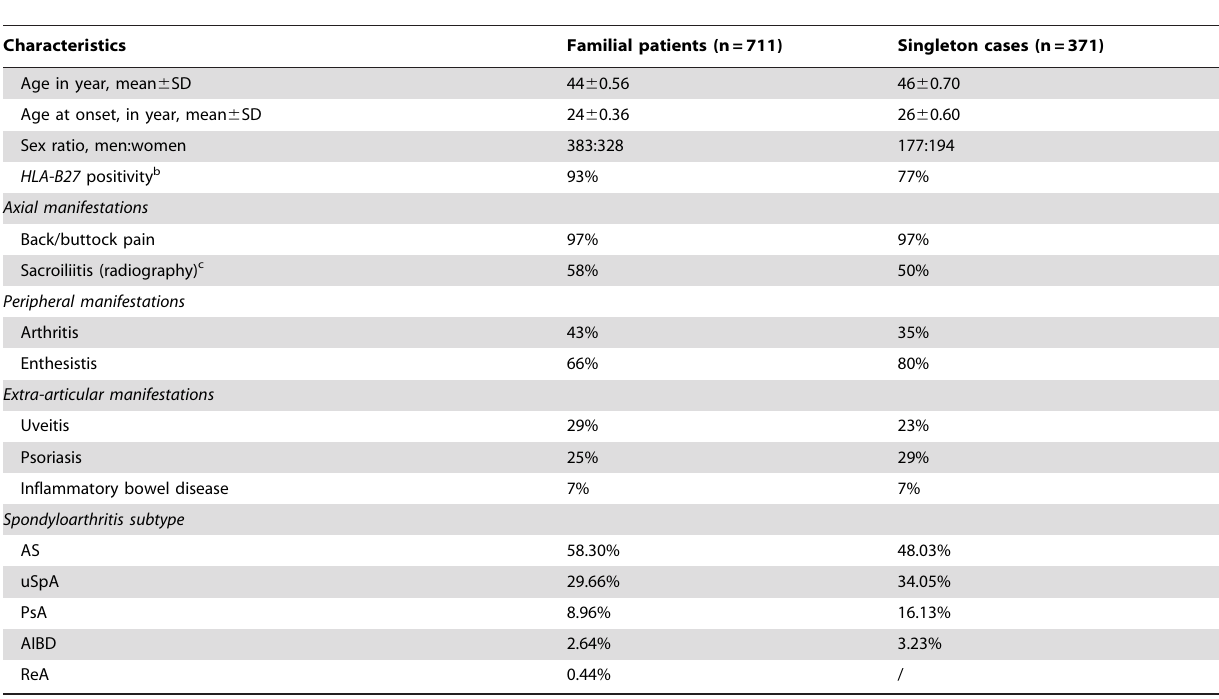
Table 5. Clinical characteristics of patients with spondyloarthritis included in the whole study. a